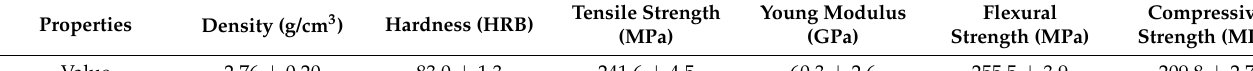
Table 3. Properties of matrix materials.